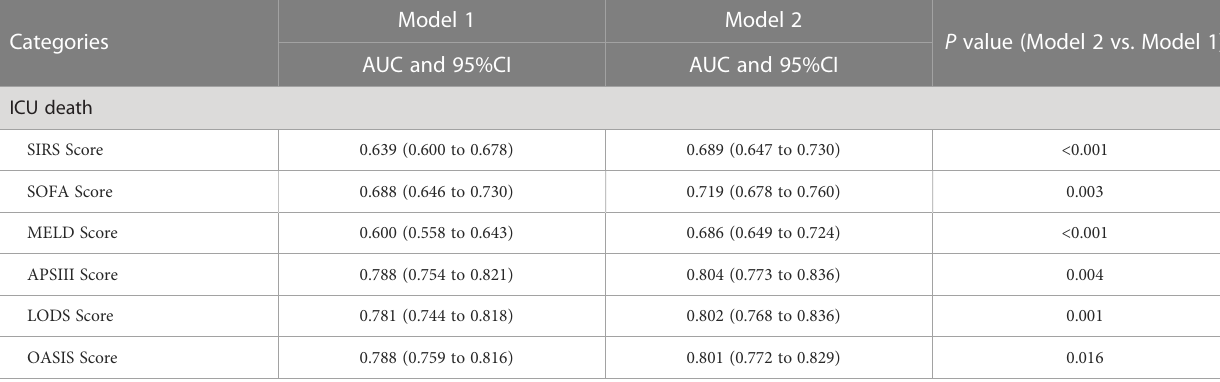
TABLE 3 Incremental effect of SHR in predicting ICU all-cause death.